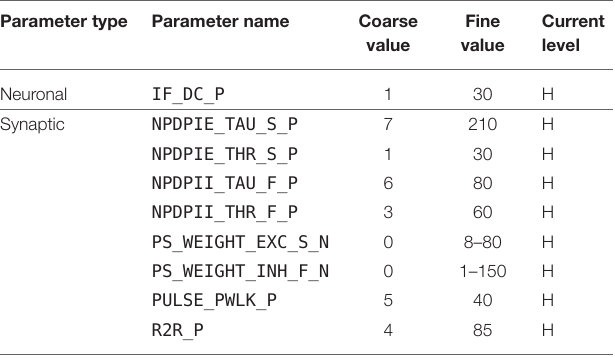
TABLE 2 | Bias parameter values used for configuration of the disynaptic delay elements in the DYNAP-SE.